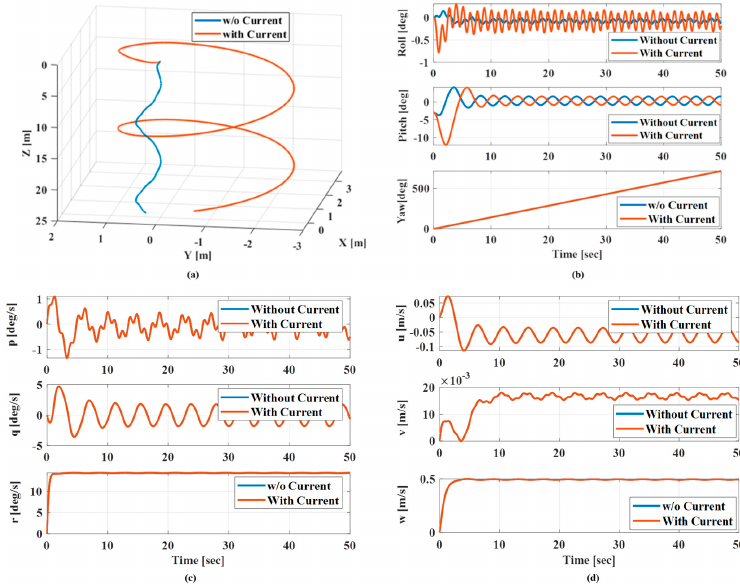
Figure 16. Simulation results of dynamic behavior of UUV (Blue line: without disturbance, Orange line: with disturbance): ( a ) X - Y - Z Trajectory of UUV when turning motion; ( b ) Euler’s Angles of UUV; ( c ),( d ) Linear & Angular Velocity of UUV.